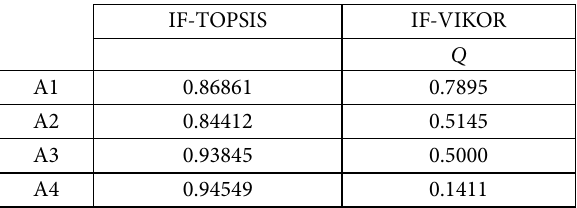
Table 6. Comparison of final scores for candidate